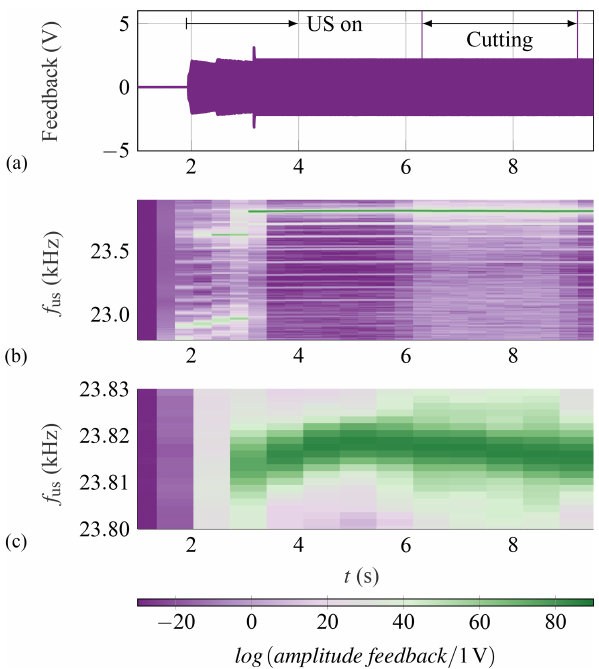
Figure 6. The feedback signal of the transducer (a) , the resulting FFT (b) and a magnification at the frequency range from 23.8 to 23.83kHz (c)